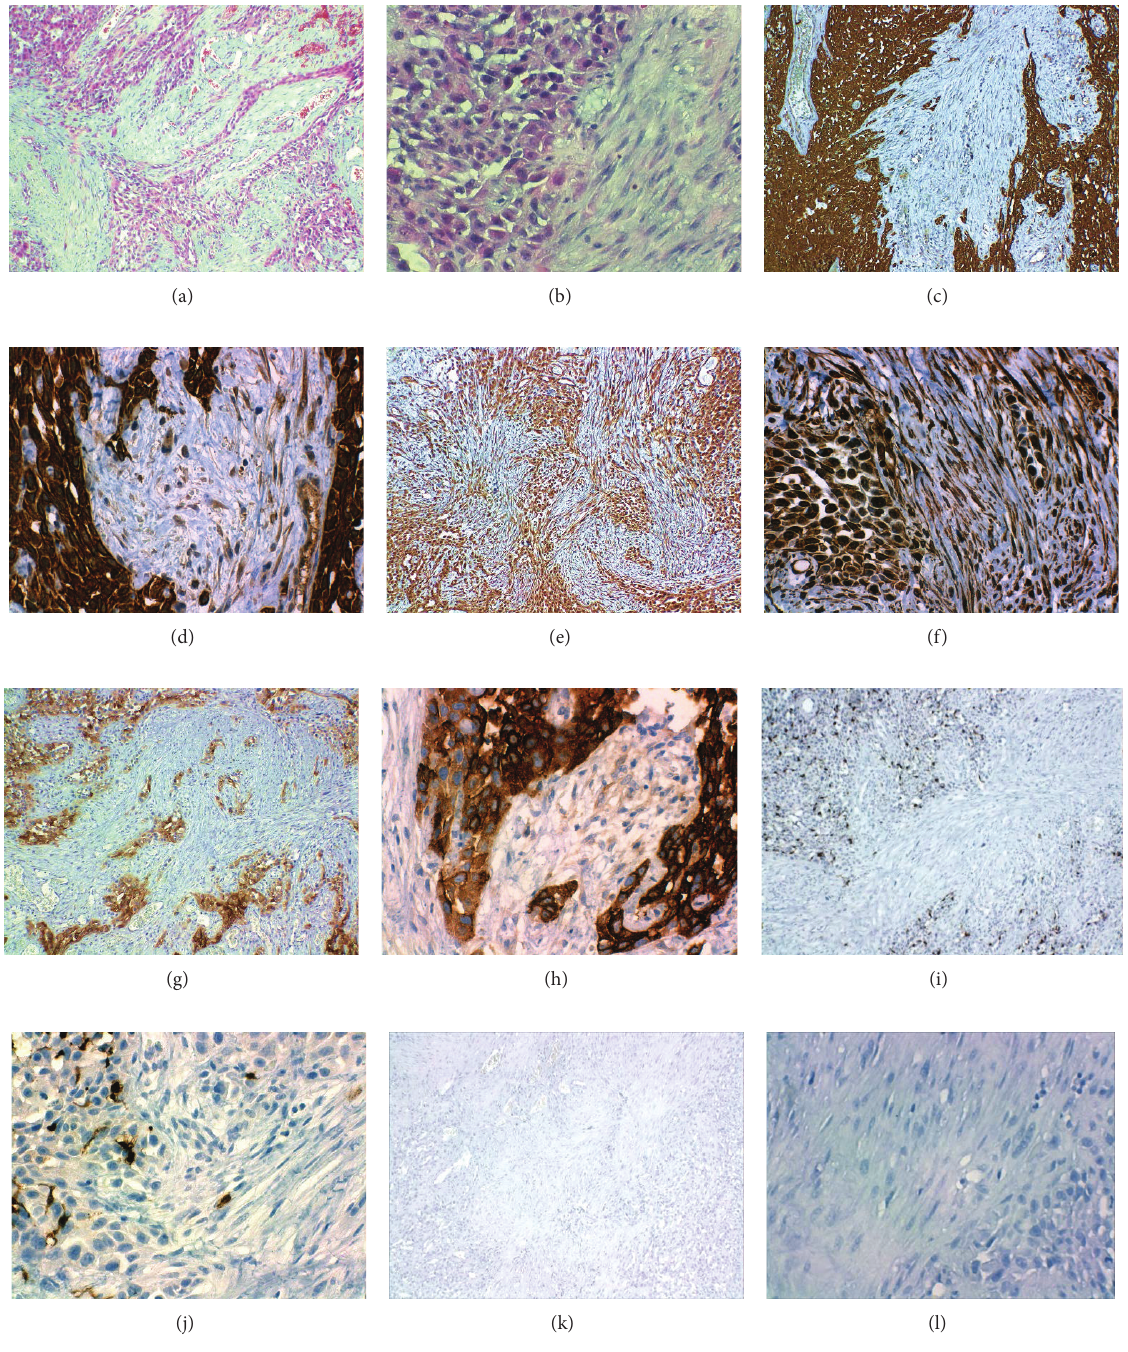
Figure 4: Casetwo: histopathology of the lesion. (a-b) Hematoxylin-eosin staining of CS. IHC staining for cytokeratin AE1/AE3 (c-d); intense staining was observed in all epithelial cells, and a diffusestaining in spindlecells. Vimentin staining (e-f)shows intenseexpression of epithelial neoplastic cells and spindle component. EMA intense expression in epithelial cells and weak staining for spindle cells (g-h). No expression was observed in the neoplastic cells for S-100 (i-j) or smooth muscle actin alpha